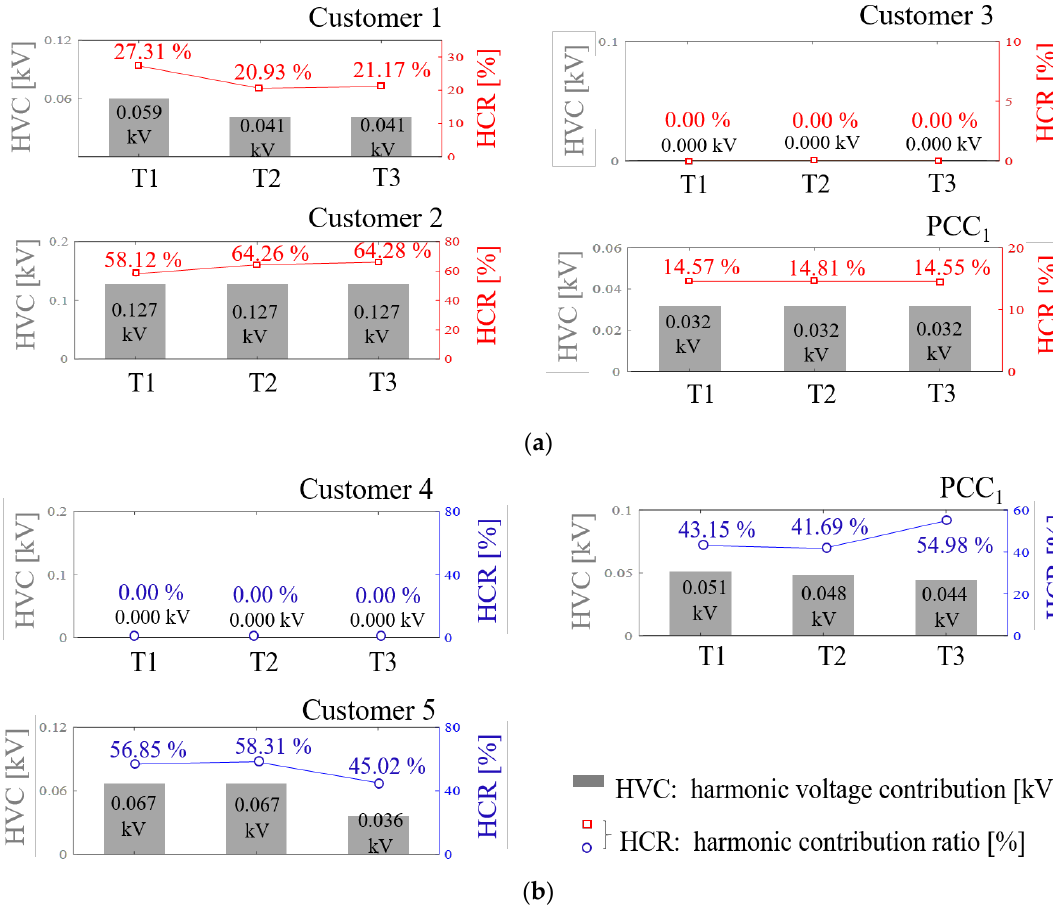
Figure 12. The assessment results of the 7th HVC and HCR. ( a ) PCC 2 . ( b ) PCC 3 .